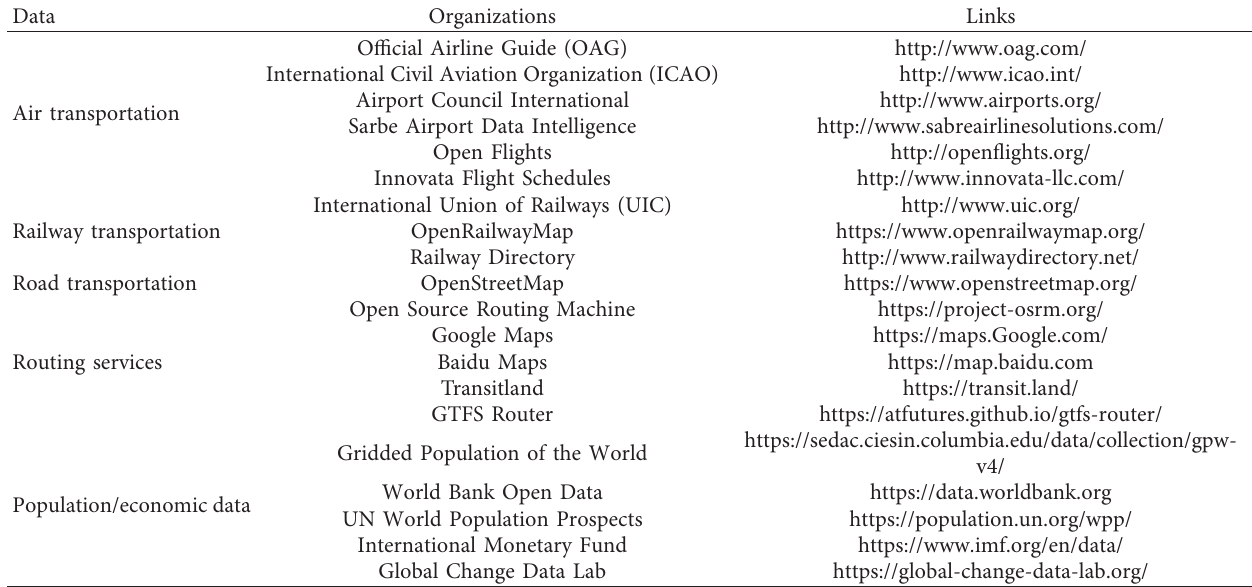
Table 7: An overview of global data sources for ODAM